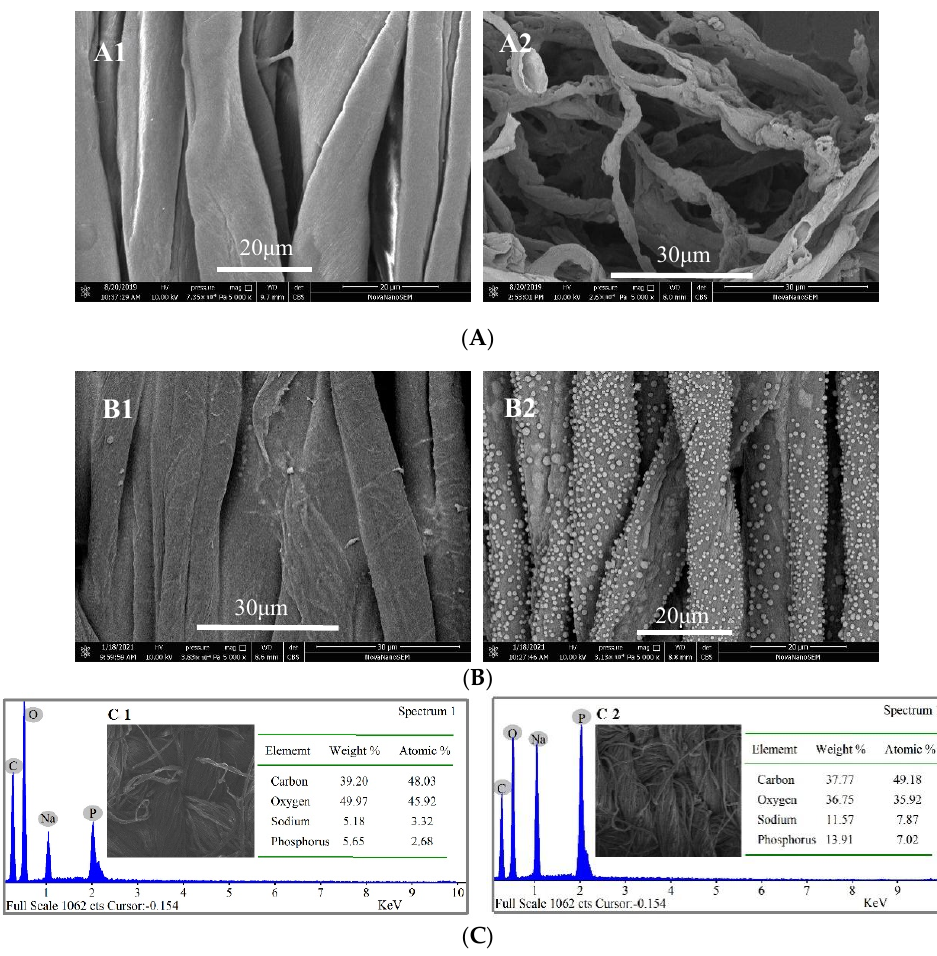
Figure 4. SEM and EDX spectrogram of fabrics: ( A ) SEM before ( A1 ) and after ( A2 ) original fabric burning; ( B ) SEM before ( B1 ) and after ( B2 ) finished fabric burning; ( C ) EDX before ( C1 ) and after ( C2 ) finished fabric burning.